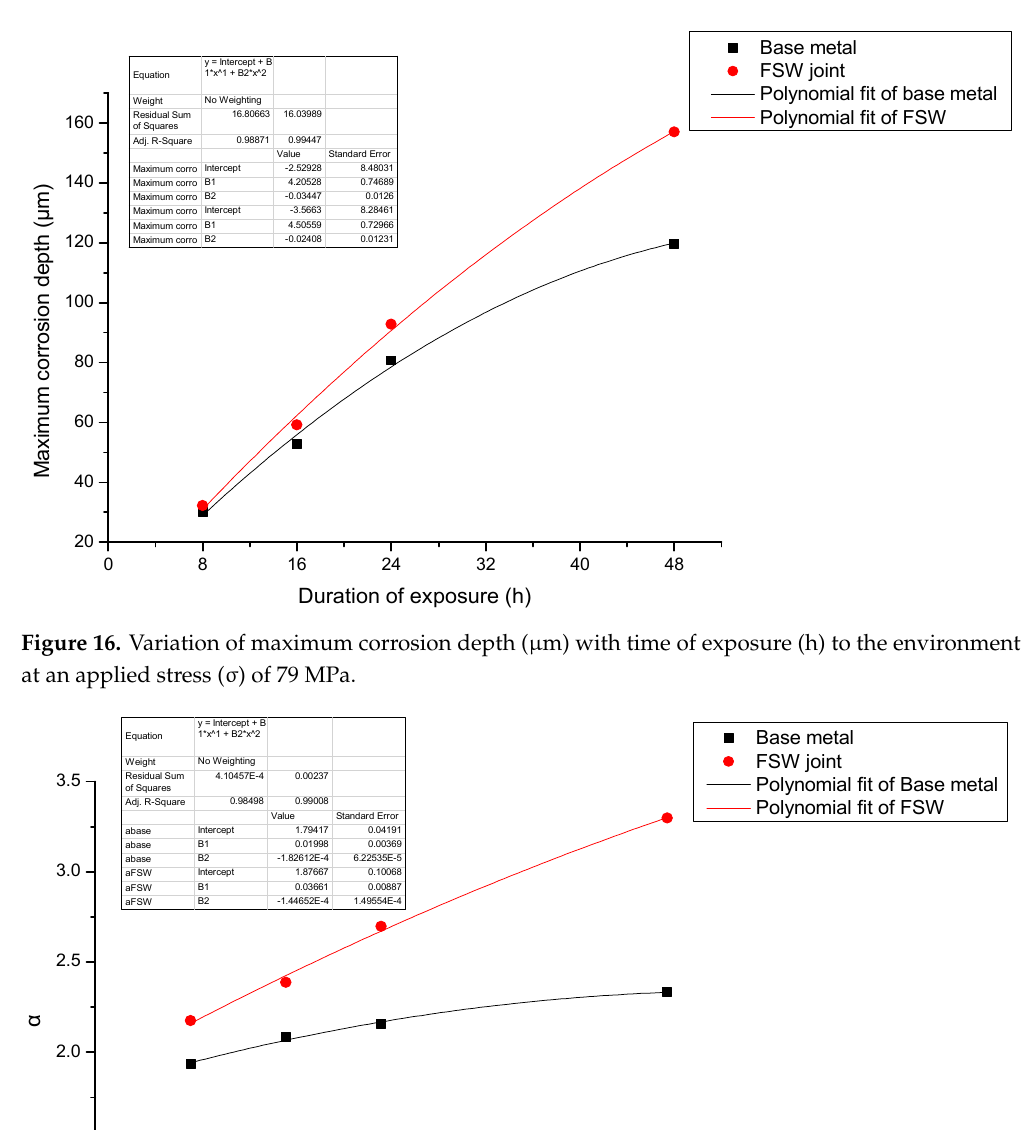
Figure 15. Variation of average corrosion depth ( μ m) with duration of exposure (h) to the environment (EXCO solution) at an applied stress ( σ ) of 79 MPa.